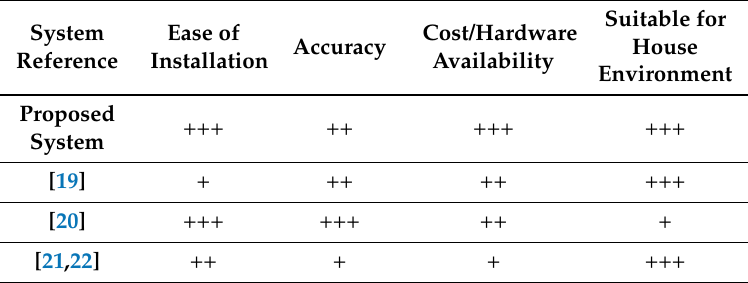
Figure 1. A diagram of the fingerprinting method. Table 1. Room localization systems